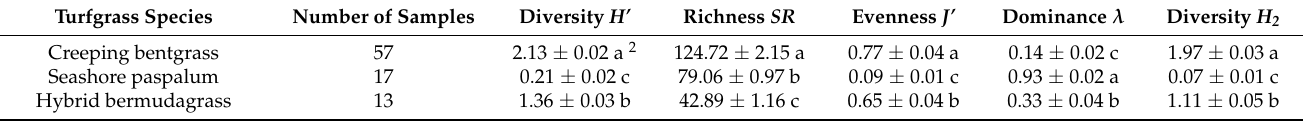
Table 6. Effect of turfgrass species on plant-parasitic nematode diversity in North, South, and East China 1